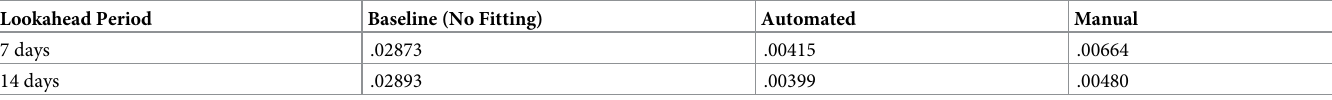
Table 2. RMSLE for the forecast periods of 7 and 14